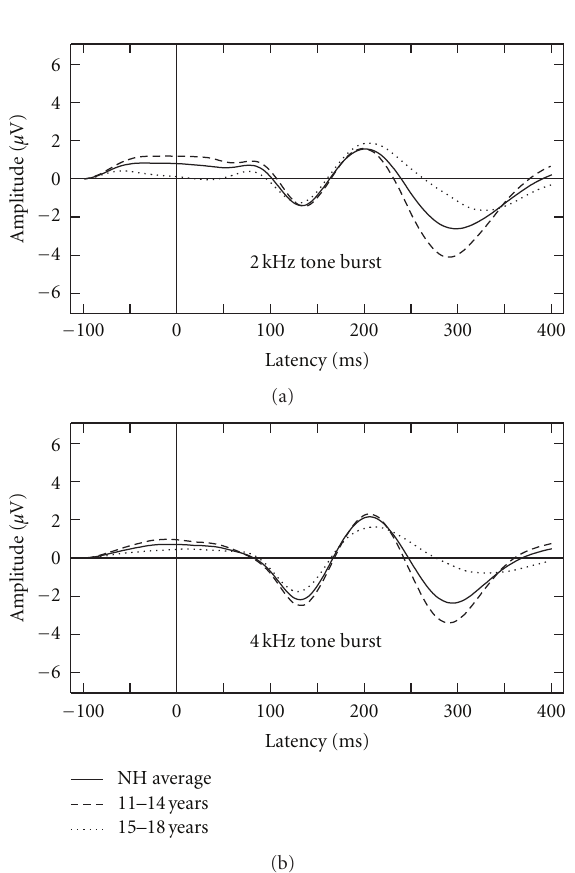
Figure 2: Averaged waveforms displayed according to stimulus for all NH groups including an average of all participants (solid line), those between the ages of 11 to 14 years (dashed line) and those between the ages of 15 to 18 years (dotted